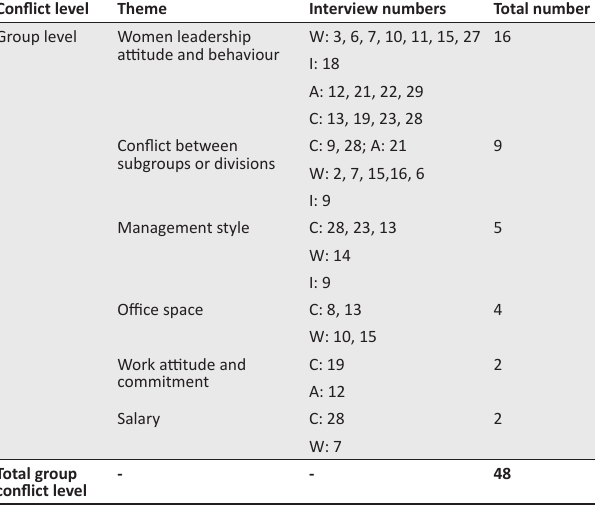
TABLE 2: Conflict on group level of women